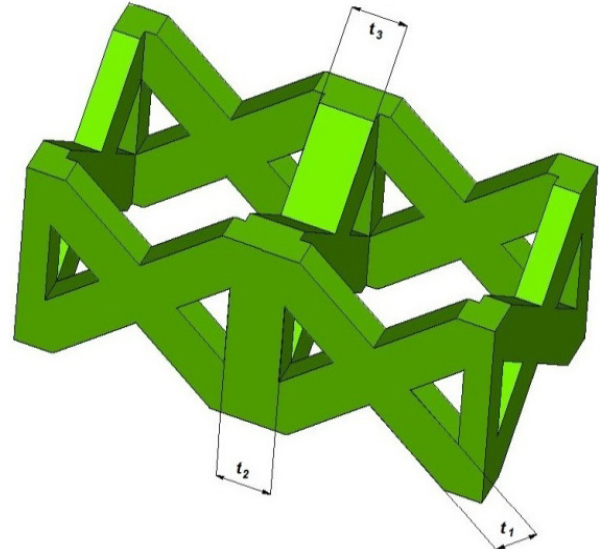
Figure 3. Truss thickness measured via